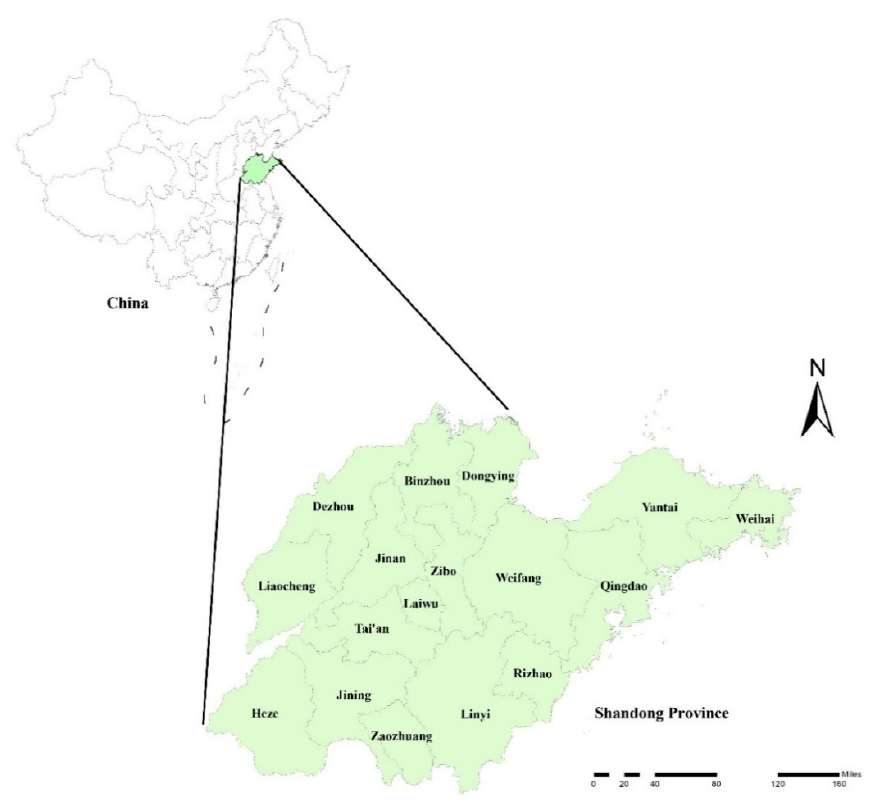
Figure 1. Location of the study area in